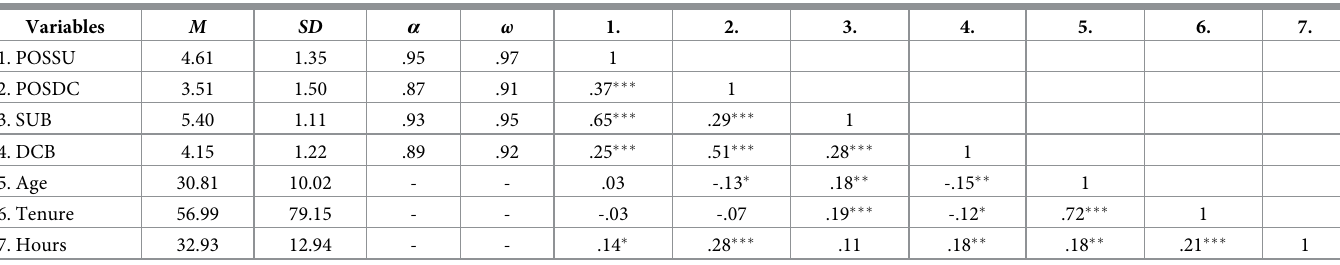
Table 3. Descriptive statistics and inter-correlations for Study